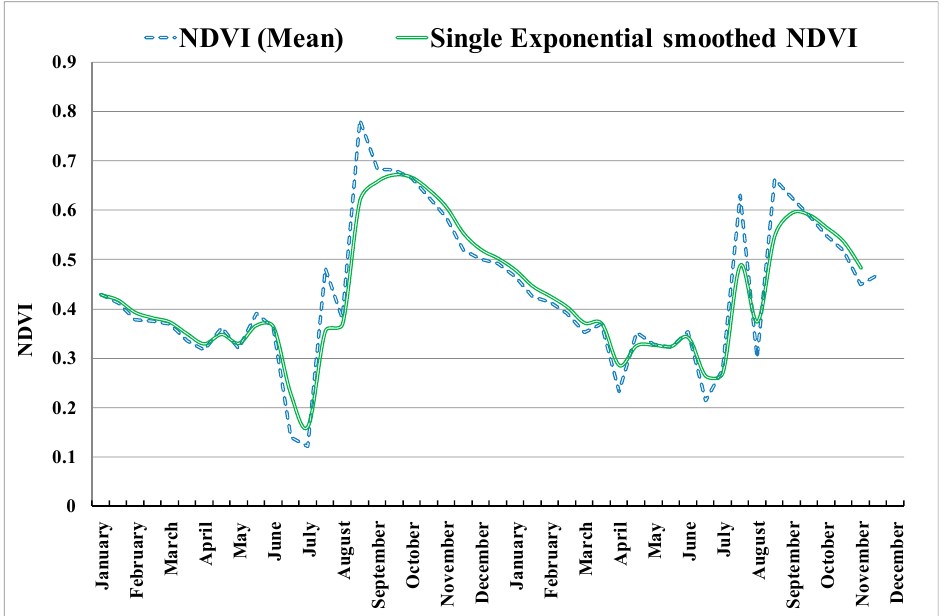
Figure 2. NDVI time series for year 2013–2014 reconstructed using single exponential smoothing.